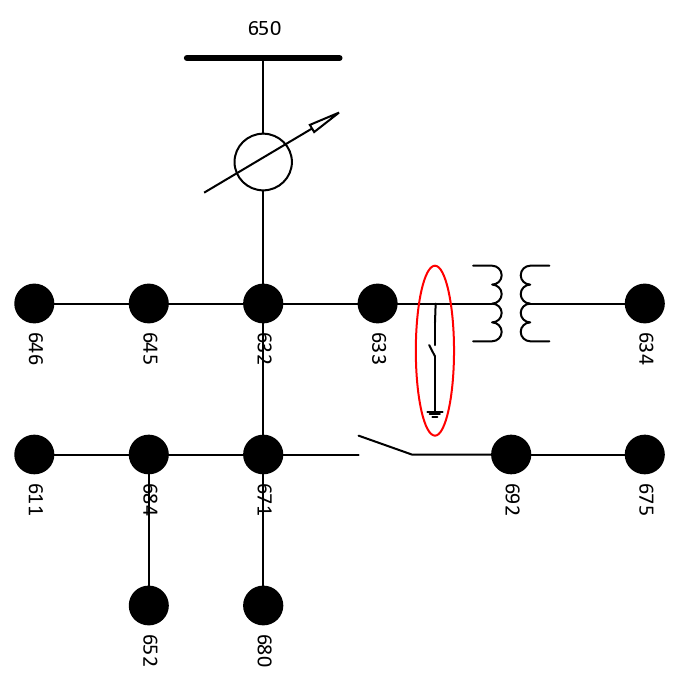
Figure 3. Phase-to-earth short circuit occurrence point—Case study 1.